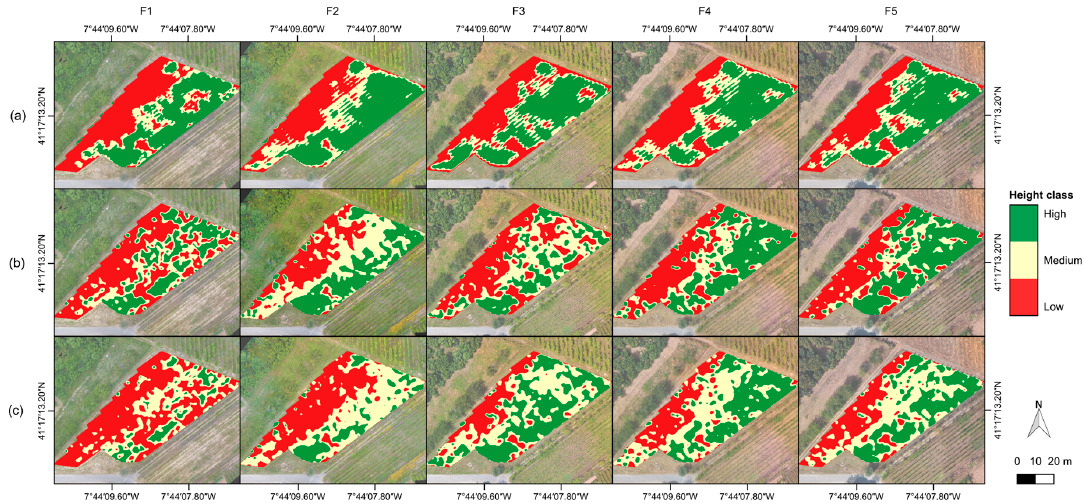
Figure 9. Generated height maps obtained from the crop surface models (CSM) for each flight campaign. Each height value was sorted into one of three height classes (low, medium, or high). The whole vineyard ( a ), grapevines’ vegetation only ( b ), and normalized grapevines’ vegetation ( c ) was considered. From the CWSI, maps that could potentially point out grapevines’ water stress were obtained.